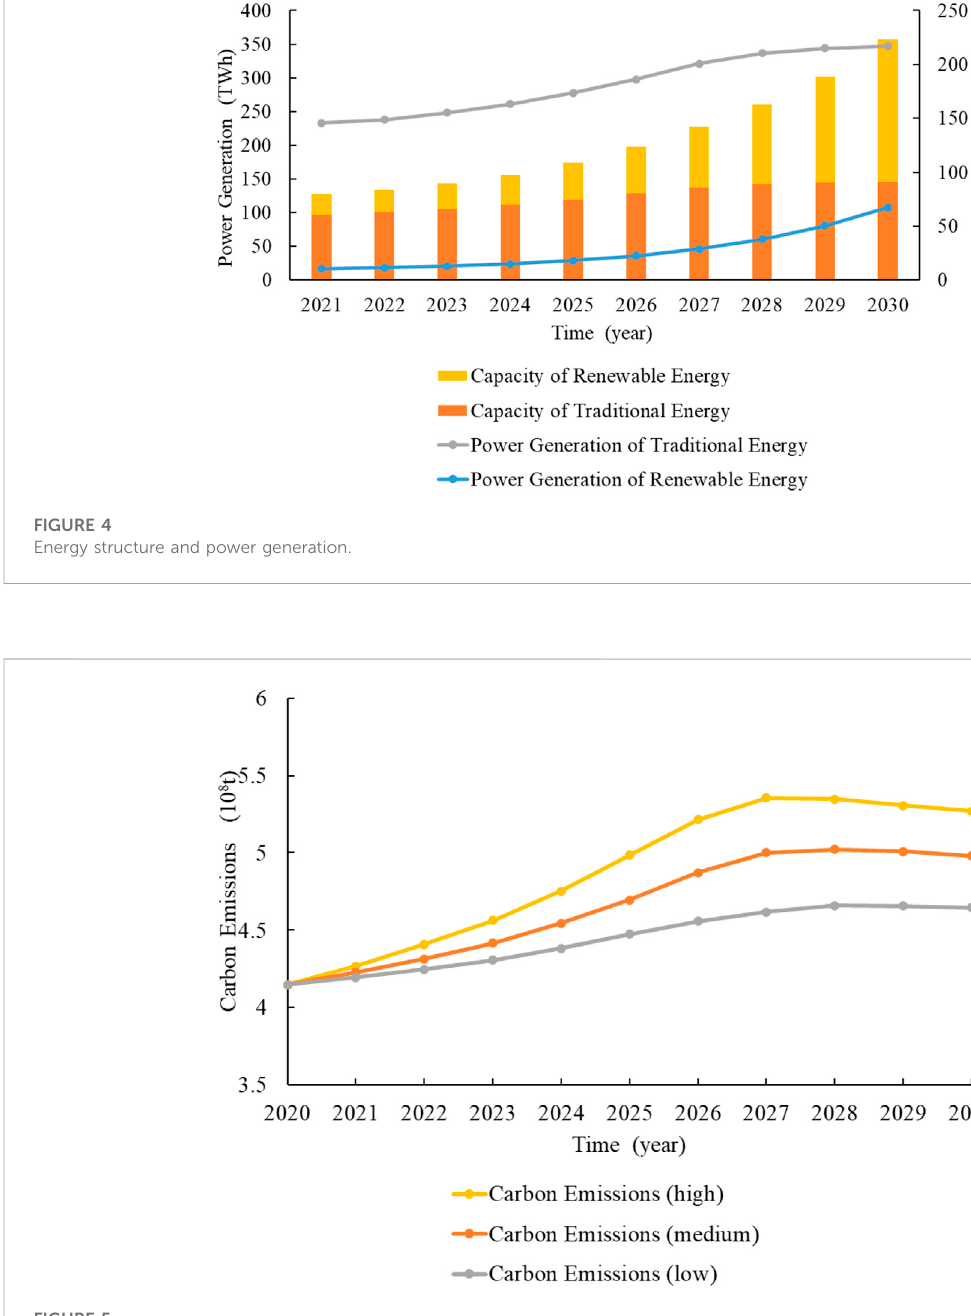
FIGURE 5 Carbon emissions under three